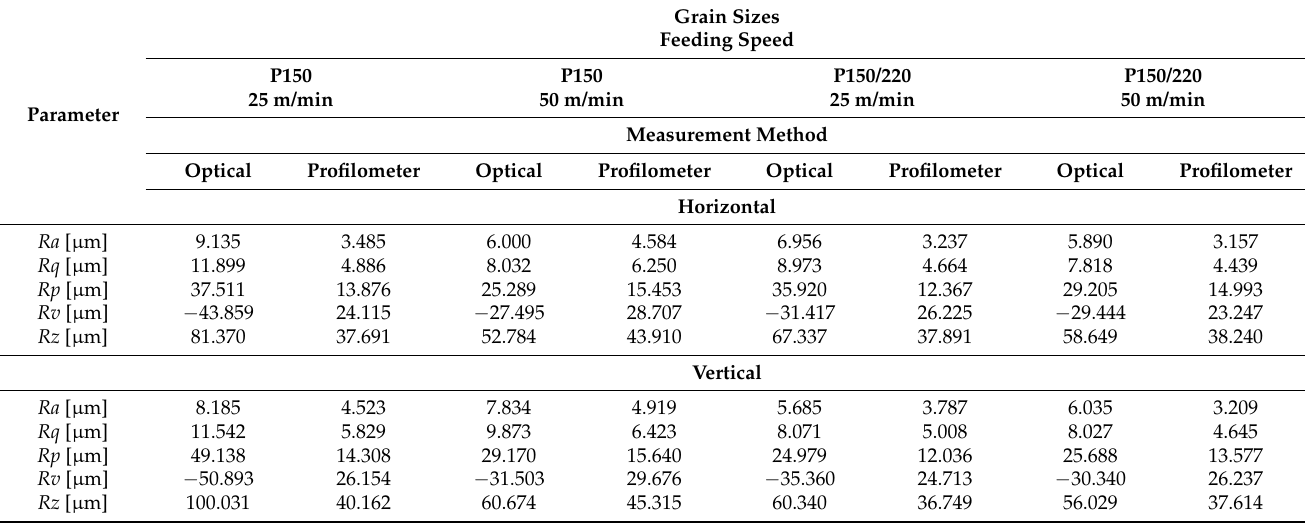
Table 4. Roughness parameters for the A board.